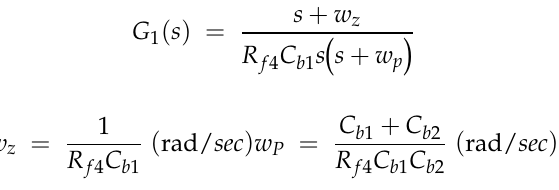
Figure 6. Simplified circuit diagram of dual-mode control